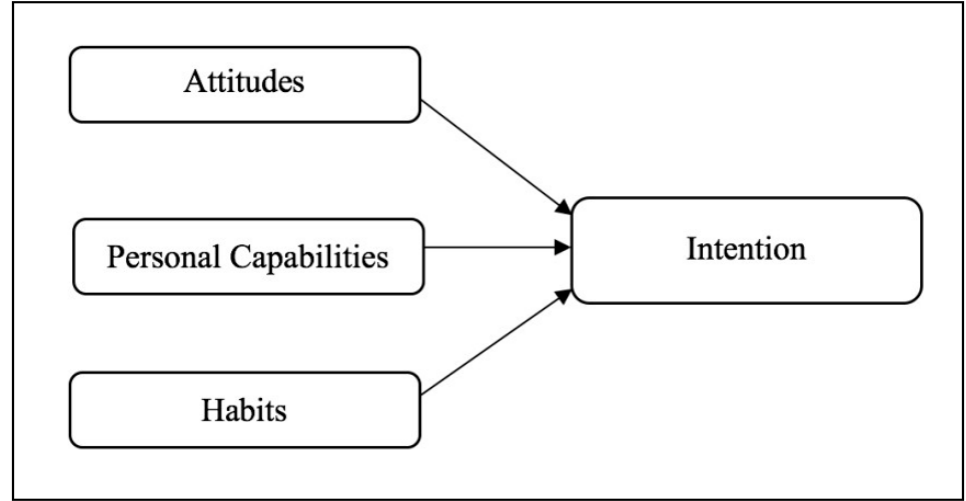
Figure 1. Proposed conceptual framework of pro-environmental behavior: Subset I. Model testing the relationship between Pro-Environmental Attitudes (Attitudes), Personal Capabilities, Habits, and Pro-Environmental Intention (Intention).